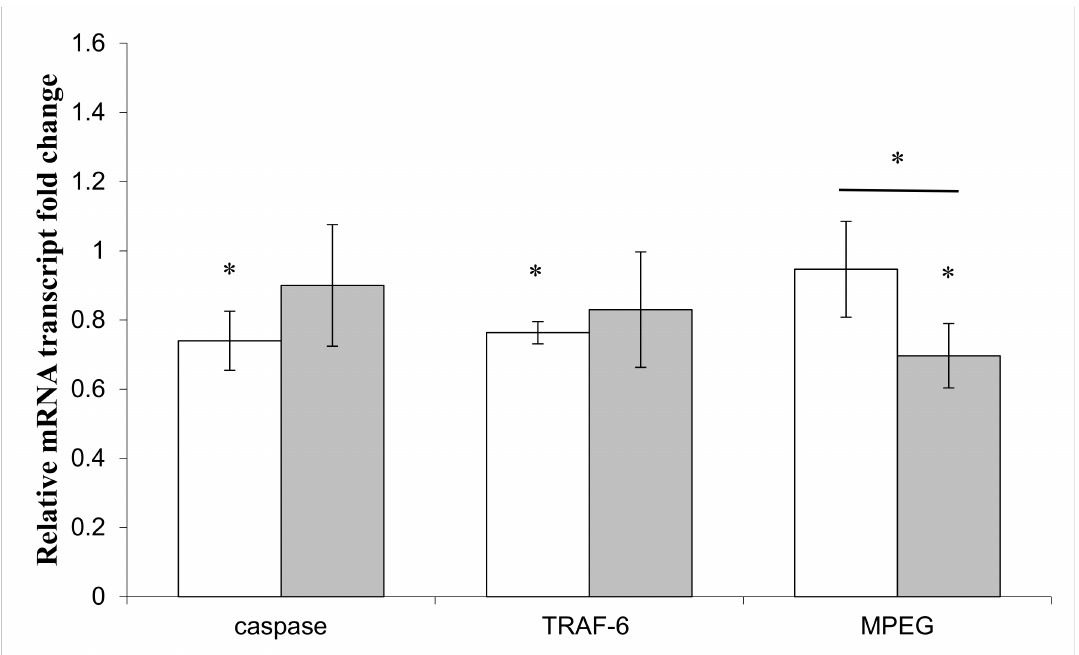
Figure 2. Expression of the macrophage expressed gene (MPEG), Tumor Necrosis Factor receptor associated factor 6-like protein (TRAF-6) and caspase genes in primmorphs co-cultivated in the presence of alive sponge-isolated bacteria; Endozoicomonas sp. Hex311 ( ) or Pseudolateromonas sp. 1A1 (